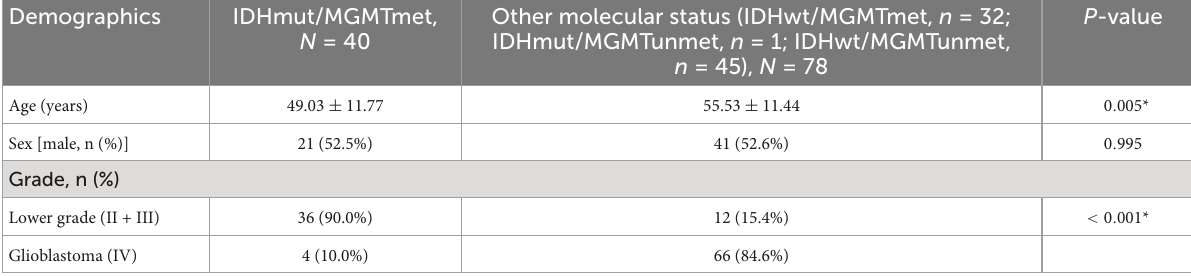
TABLE 1 Comparison of sex, age, and pathological grade between IDHmut/MGMTmet and the other glioma group.